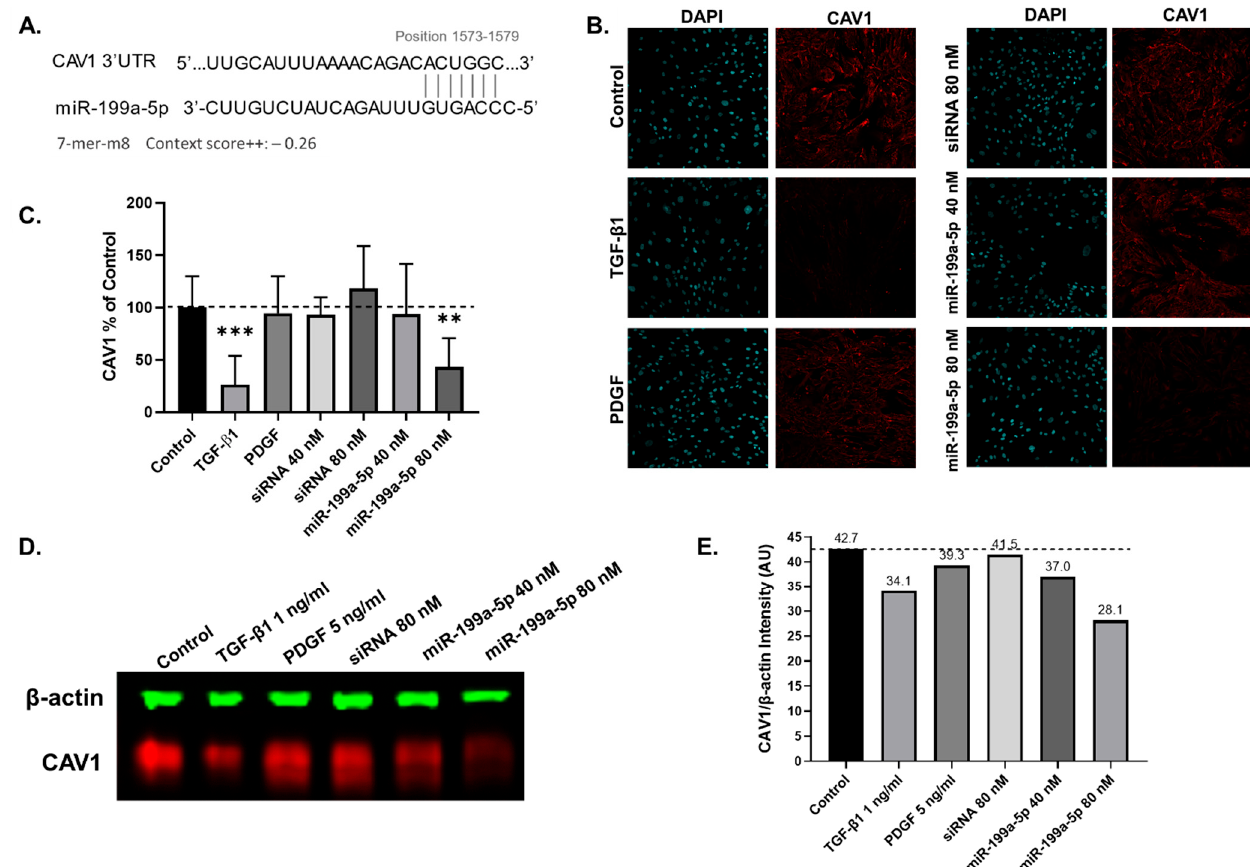
Figure 8. Identification of potential targets of the four selected miRNAs. Following the literature review, CAV1 was identified as a potential target for miR-199a-5p and was confirmed using TargetScan (accessed on 7 June 2021), where miR-199a-5p was found to target CAV1 on positions 1573–1579 with an exact match to positions 2–8 of the mature miRNA. The context score++ is − 0.26, of which 1 = lowest repression capacity and − 1 = highest repression capacity ( A ). hTERT-HSC were transfected for 72 h with miR-199a-5p mimic and were fixed or collected in RIPA buffer at 72 h. Potential target CAV1 was assessed using immunostaining, showing a decrease in TGF- β 1-treated and miR-199a-5p-transfected hTERT-HSCs, which was confirmed following quantification using ImageJ ( B , C ). These findings were corroborated using Western blot analysis ( D ), which were quantified using the Li-Cor Image Studio to obtain intensity (AU) of CAV1/ β -actin ( E ). Student’s unpaired t test; **, p ≤ 0.01; ***, p ≤